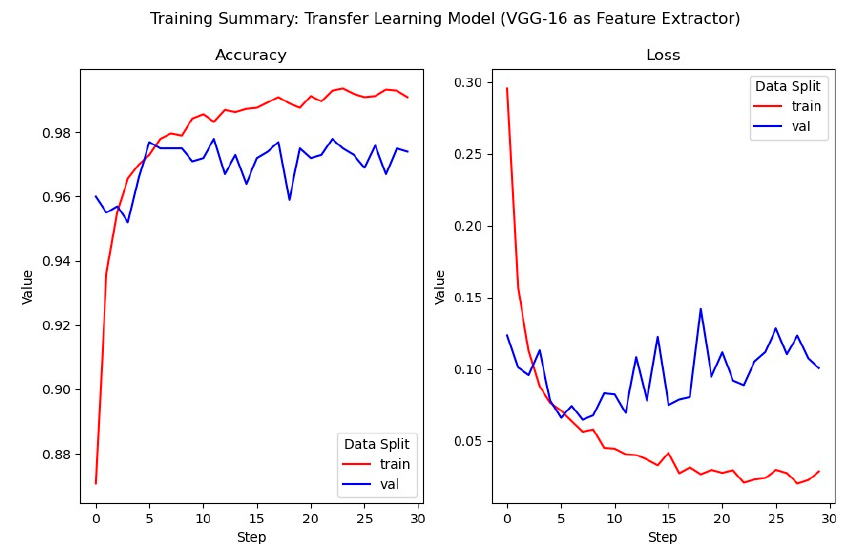
Figure 10. Training summary of the VGG-16 feature extraction model.